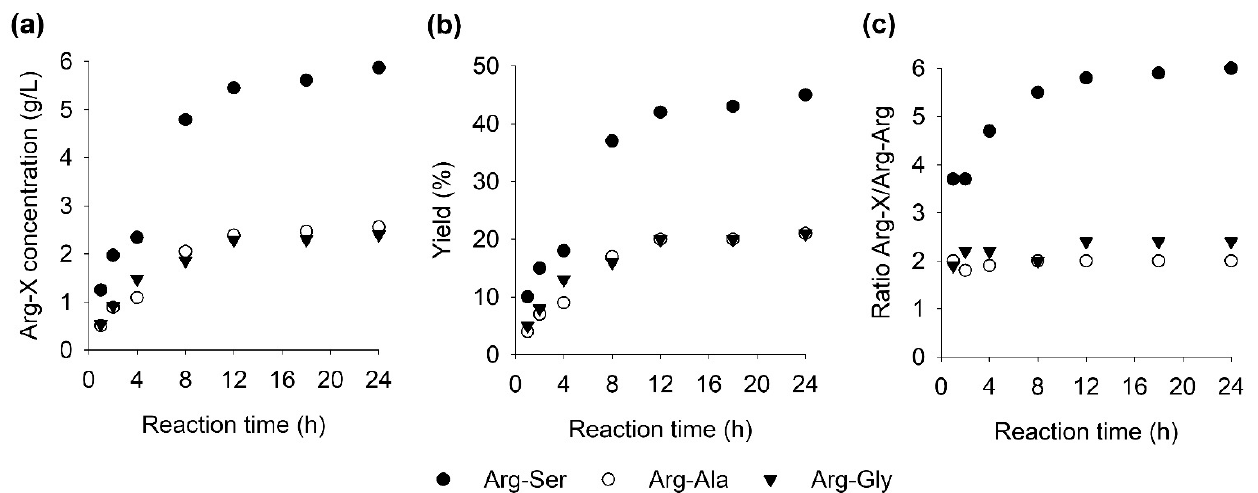
Figure 6. Time course of dipeptide formation with optimized reaction conditions: 50 mM amino acids and AcP; 0.5 mM ATP; 7.5 mM Mg 2+ ; 0.4 mg/mL RizA; 0.1 mg/mL AckA; 25 ◦ C; pH 9.0 ( a ) Product concentrations of Arg-Ser, Arg-Ala and Arg-Gly. ( b ) Yields of respective Arg-X dipeptides. ( c ) Ratio of main product Arg-X to side product